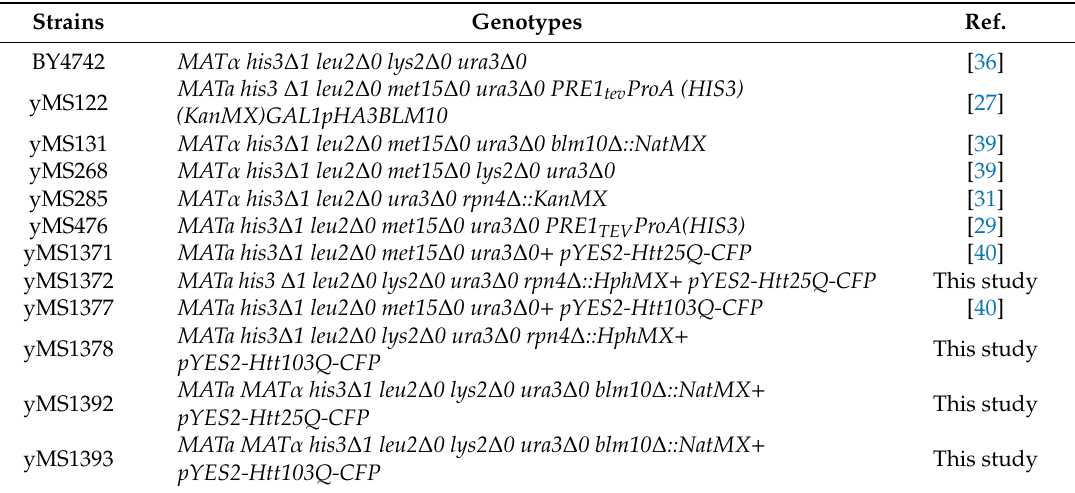
Table 1. Strains used in this